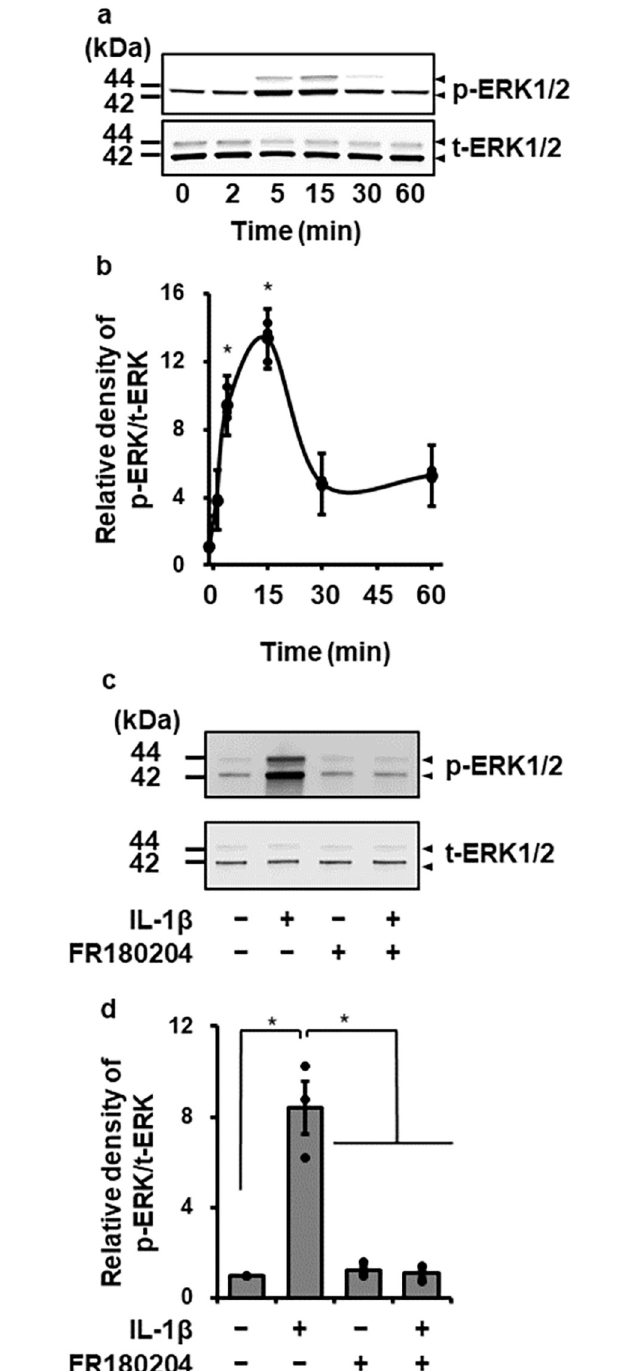
Fig 3. IL-1 β -induced activation of ERK1/2. (a, b) Time-dependent changes of ERK1/2 phosphorylation. Western blotting for the levels of phosphorylated ERK1/2 (p-ERK1/2) and total ERK1/2 (t-ERK1/2) in dermal fibroblasts treated with IL-1 β (100 pM) (a) and relative levels of [p-ERK1/2]/[t-ERK1/2] in IL-1 β -stimulated cells compared to the levels at 0 h (b). (c, d) Effect of an ERK1/2 inhibitor on IL-1 β -mediated ERK1/2 phosphorylation. Fibroblasts were pretreated with or without the ERK1/2 inhibitor FR180204 (50 μ M) for 1 h and stimulated with IL-1 β for 15 min. Representative Western blotting result of inhibitory effect of the ERK1/2 inhibitor on IL-1 β -mediated ERK1/2 phosphorylation (c) and relative levels of [p-ERK1/2]/[t-ERK1/2] as compared to those without the inhibitor and IL-1 β (d). Results have been represented as mean ± SE from biological triplicates. � P < 0.05.